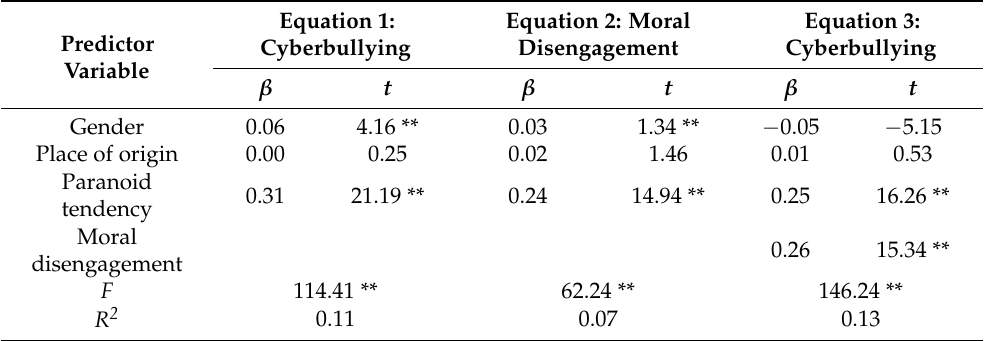
Table 3. Analysis of the mediating effect between paranoid tendencies, moral disengagement, and cyberbullying behavior.